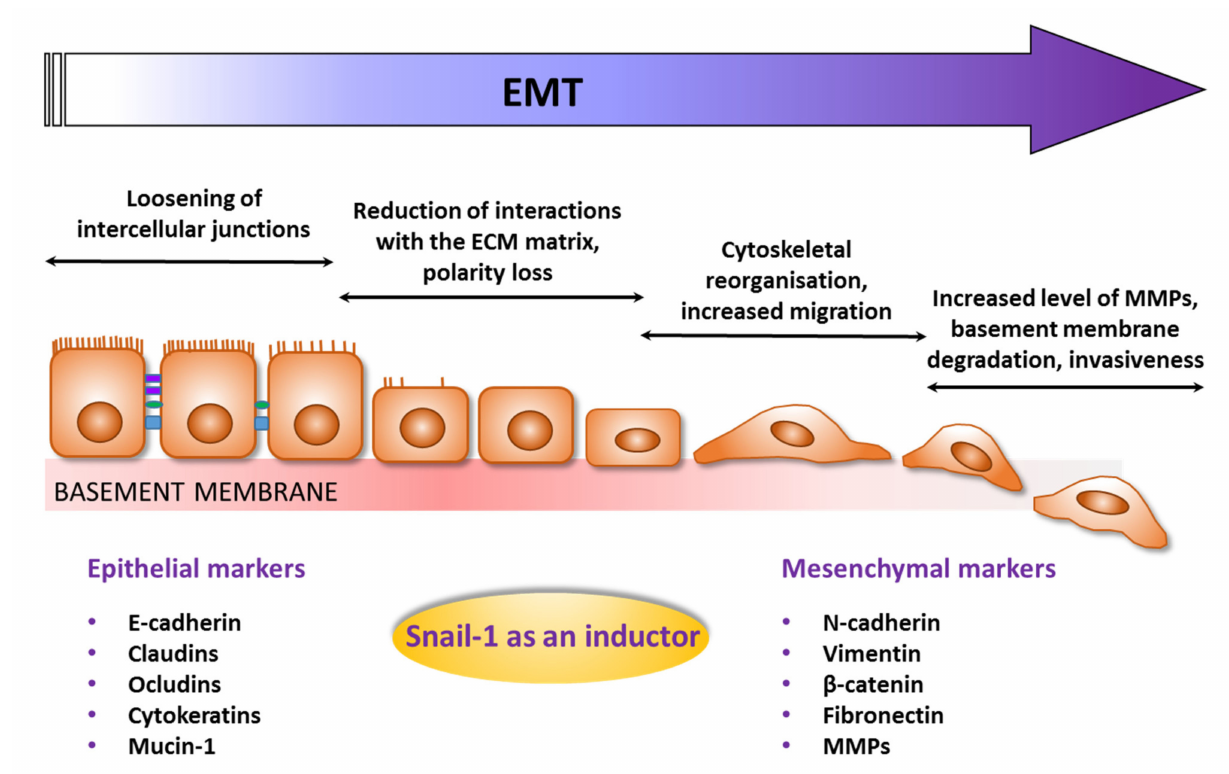
Figure 1. Schematic steps of the EMT process with examples of epithelial and mesenchymal markers (ECM—extracellular matrix; MMPs—matrix